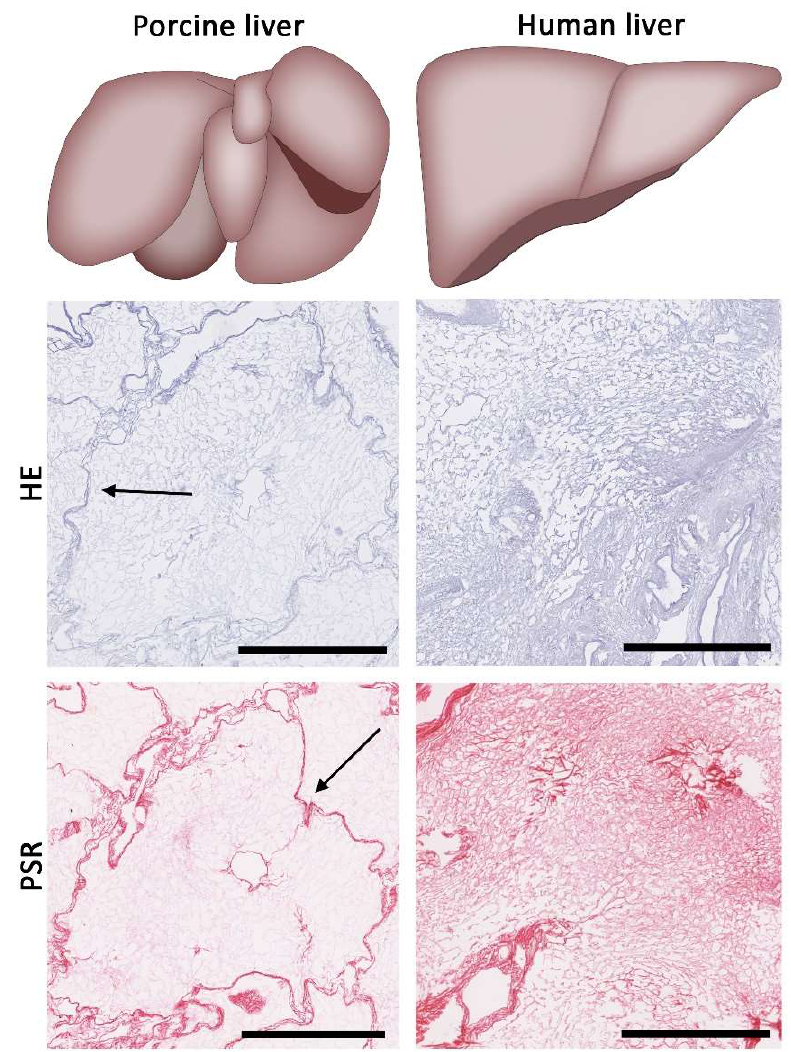
Figure 3. Porcine livers differ from human livers from an anatomical point of view. Porcine livers have multiple lobes, but also contain septa (indicated by black arrows). These septa are not visible in human livers. The scale bars represent 500 µm.